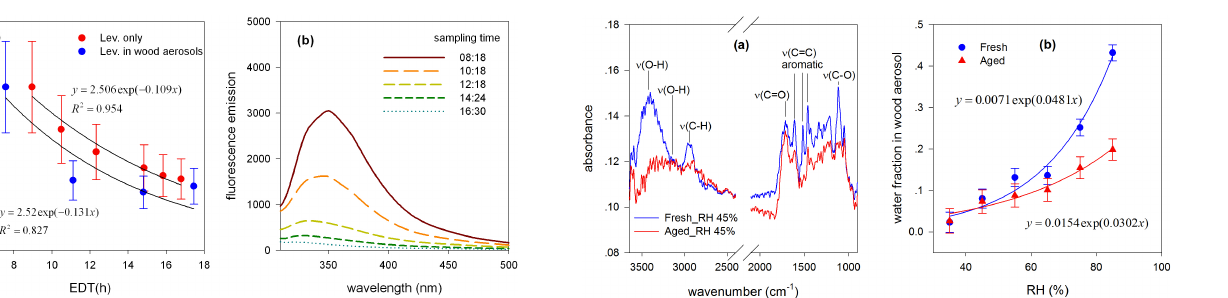
Fig. 5. (a) FTIR spectra of fresh and aged wood-burning particles sampled on 21 November 2012. The spectra were recorded at RH of 45%. (b) The water content of fresh particles and aged particles as a function of RH. The water content was measured with decreasing RH. The error associated with the water fraction in aerosol was es- timated based on aerosol mass and FTIR absorbance at 1650cm − 1